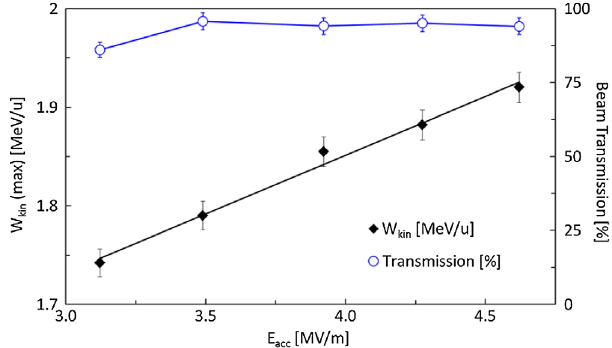
FIG. 9. Acceleration of an Ar 9 þ beam; maximum achieved beam energy and transmission as a function of the accelerating